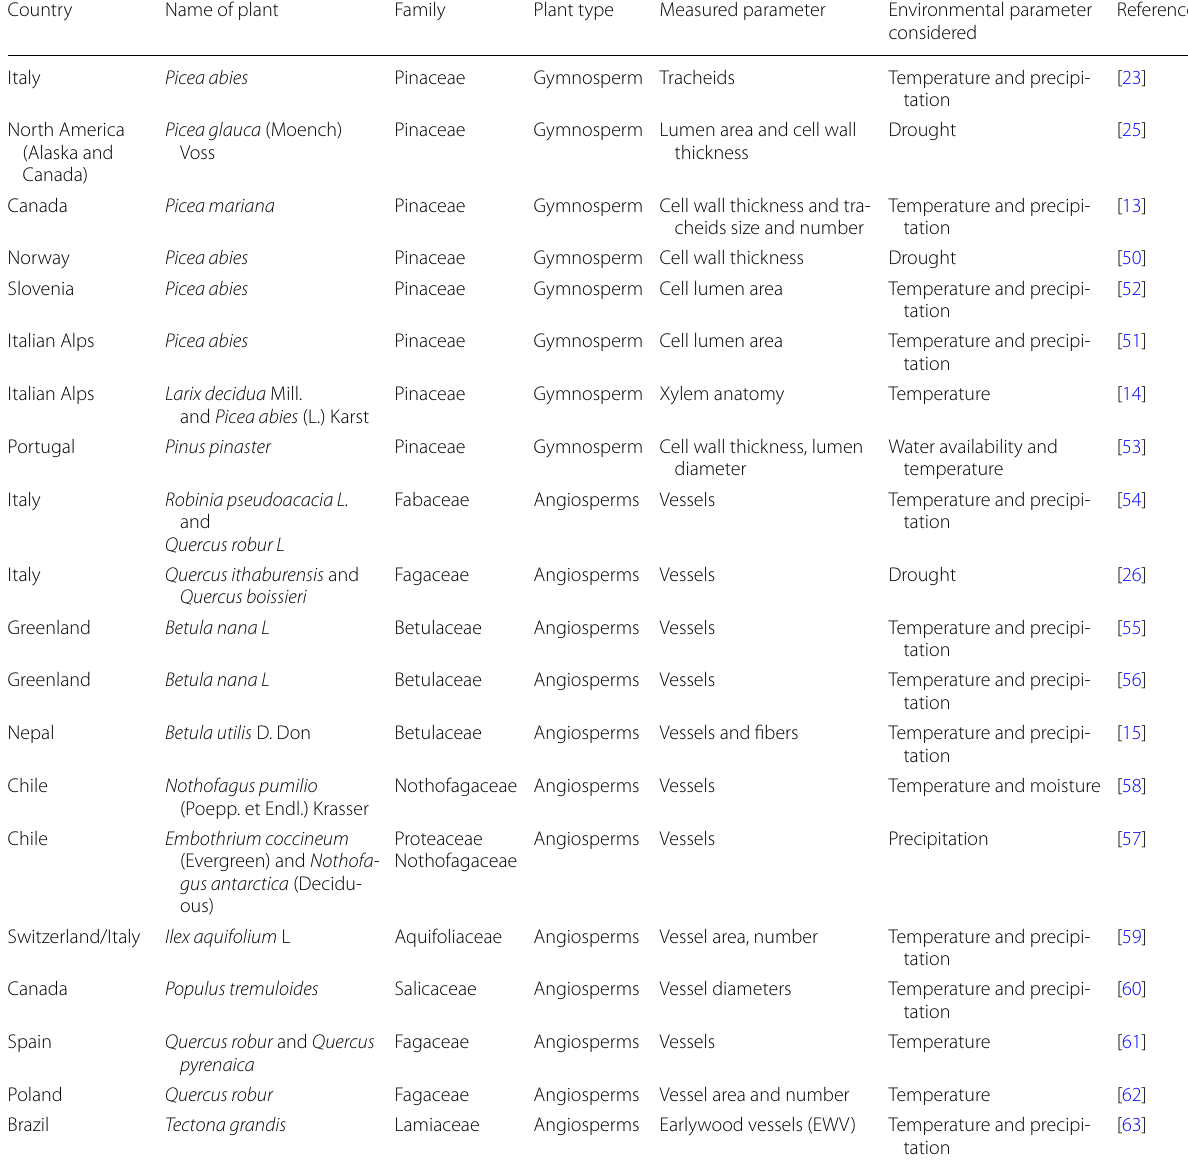
Table 2 Articles included in the study Country Name of plant